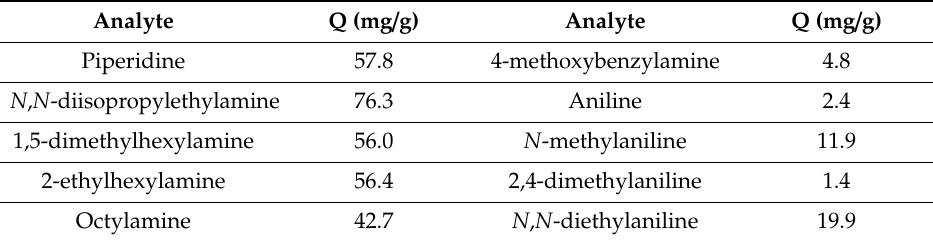
Table 2. Loading factors of the magnetic